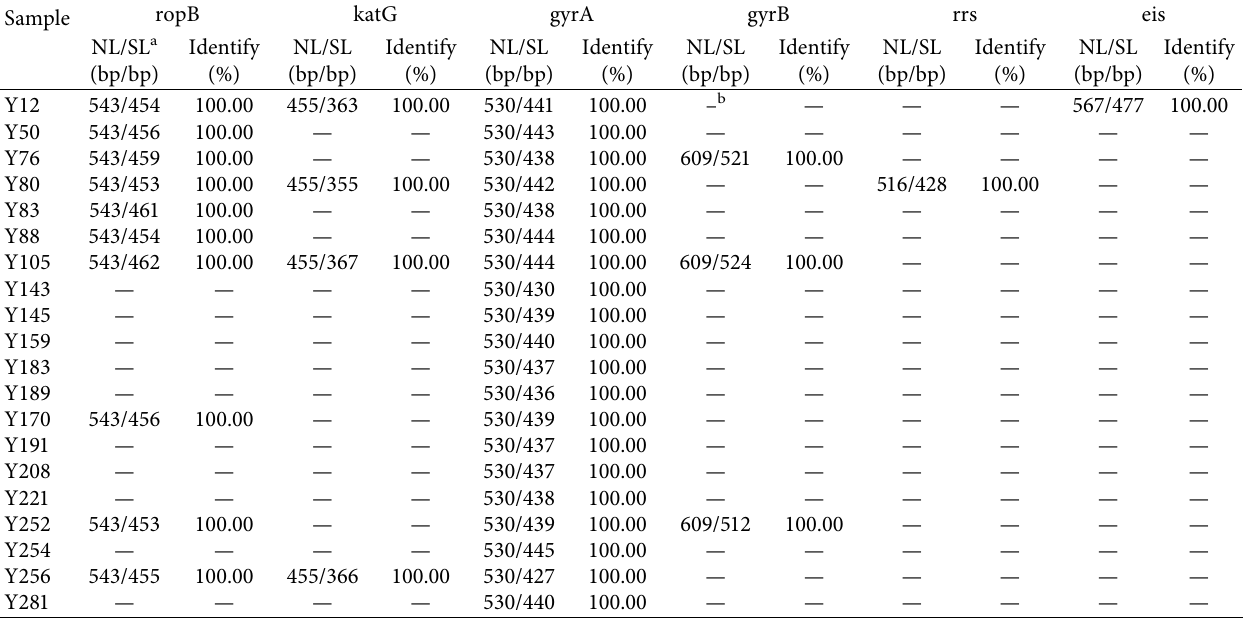
Figure 1: Depth of coverage of sequences for different genes of the 20 study samples. Table 2: Percentage (%) identify of consensus sequences to Sanger sequencing